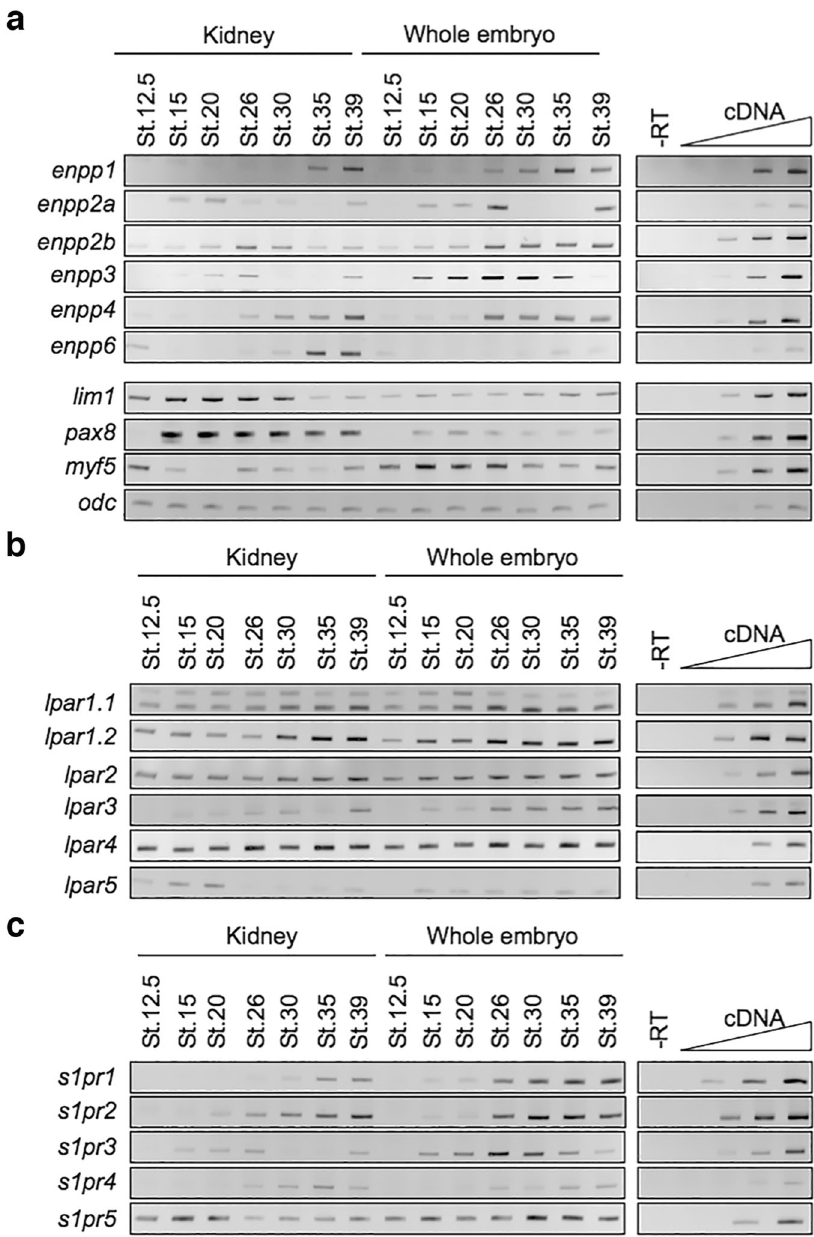
Fig. 3 The enpp and the lipidic receptors, the lpar and s1pr , gene family members are expressed in the pronephros. Developing pronephric anlagen or pronephric tubules were dissected as indicated, from whole X. laevis embryos and total RNA extracted. RT-PCR was performed on pronephric dissected tissues and control whole embryos along with negative and linearity controls. a Comparative expression pattern of the enpp genes and pronephric and muscle marker genes controlling the quality of the dissections. b Comparative expression pro fi le of the lpa receptors. c Comparative expression pro fi le of the s1pr